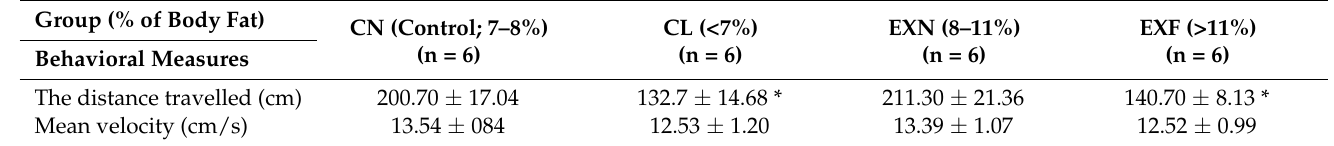
Table 6. Behavioral scores for locomotor activity in the Barnes maze in mice with various body conditions. Data are shown as mean ± SEM. Abbreviations: (CN) control group of mice characterized by normal weight and physiological percentage of body fat deposits; (CL) control group of mice characterized by reduced weight and reduced body fat deposits; (EXN) experimental group of mice characterized by normal weight and moderately elevated body fat deposits; (EXF) experimental group of mice characterized by markedly elevated weight and body fat deposits. Statistical significance of differences between experimental and control groups: * p ≤